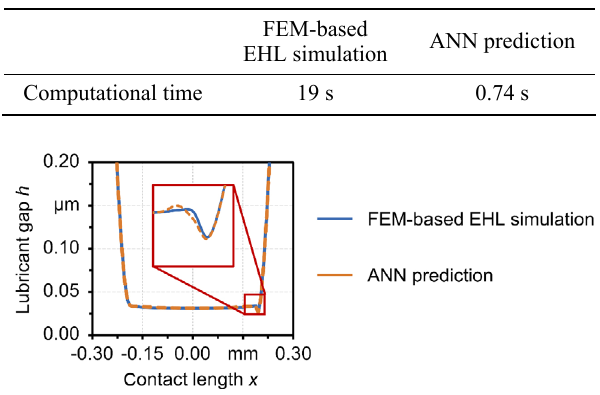
Table 12 Computational time for determining the lubricant film distribution over the contact length for a representative infinite 2D line contact using the FEM-based EHL simulation and an ANN with 15 neurons in each of the two hidden layers.